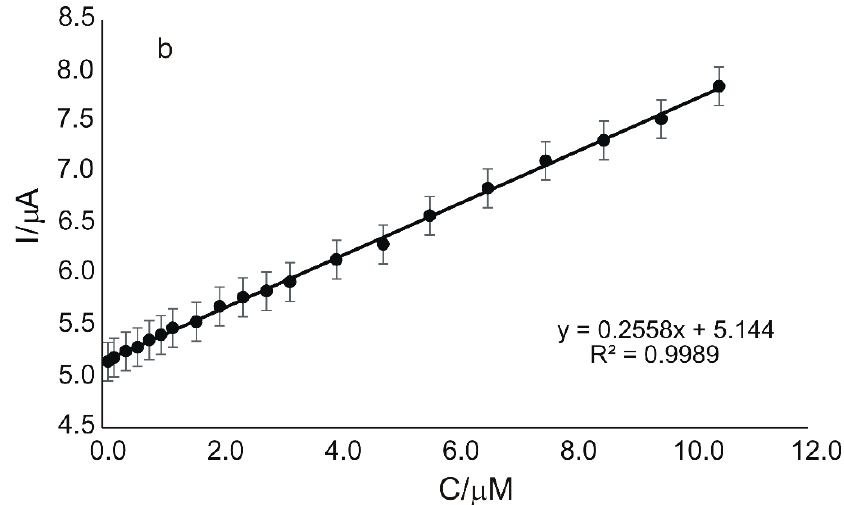
Figure 11. CVs recorded for SPCE/GPHOX-Pentapeptide with the concentration between 0.1 µM and 10.55 µM verbascoside ( a ); Linear dependence between Ipa and verbascoside concentration in the range 0.1–10.55 µM ( b ).